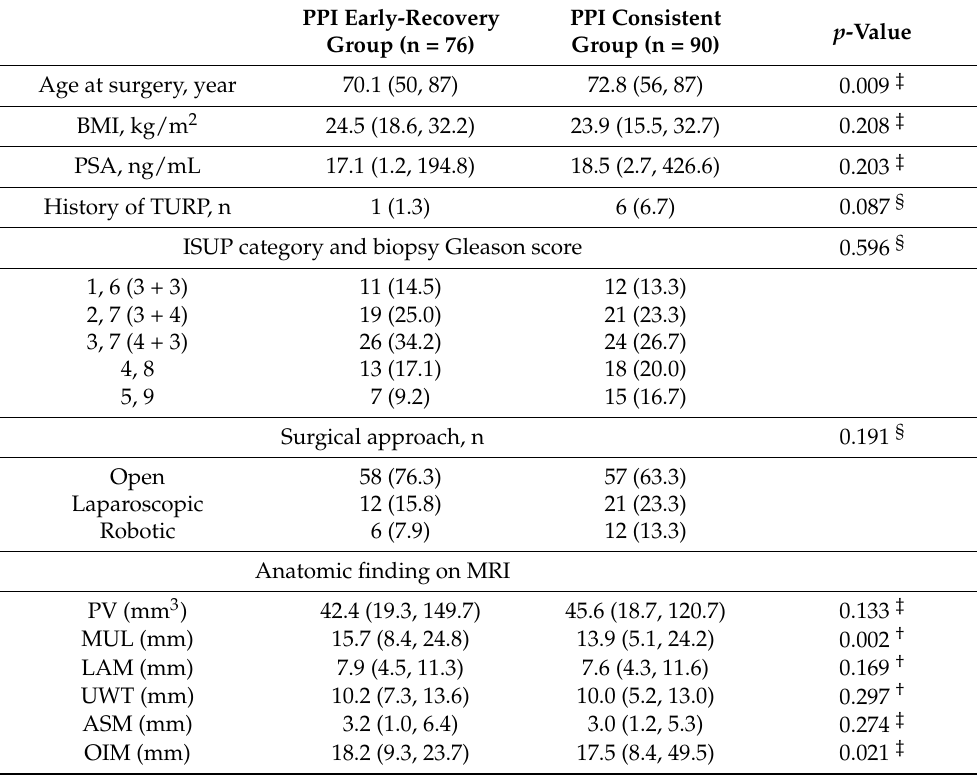
Table 3. Comparison between PPI early-recovery and consistent